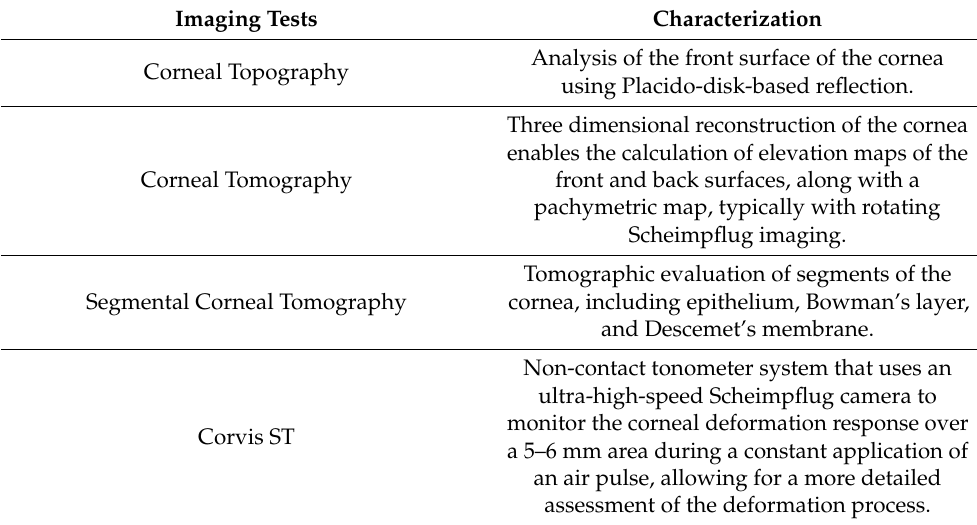
Table 2. Exams for multimodal propaedeutics in